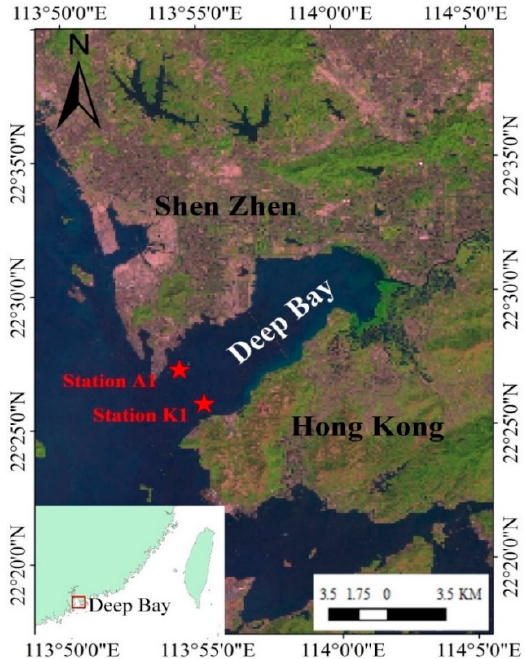
Figure 2. Location of Deep Bay, and the in situ measurements of suspended solids (SS) at stations A1 and K1.